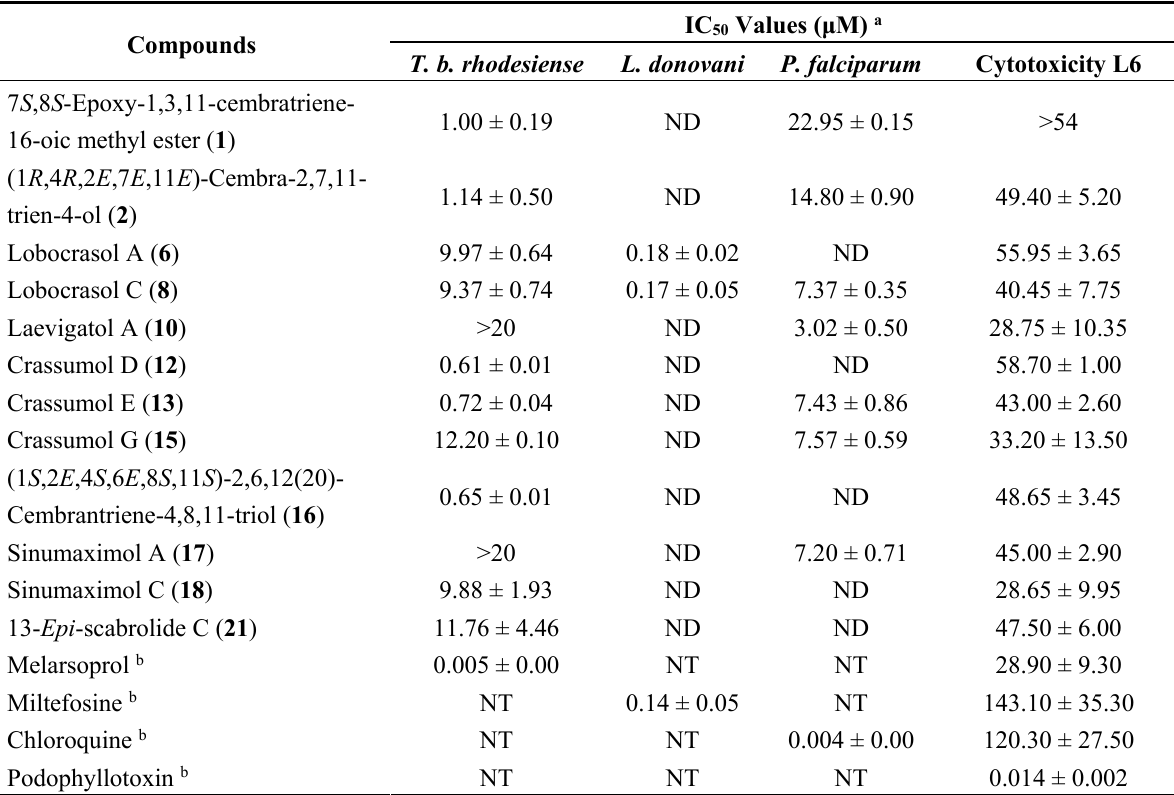
Table 1. In vitro antiprotozoal activities and cytotoxic activity of marine metabolites.